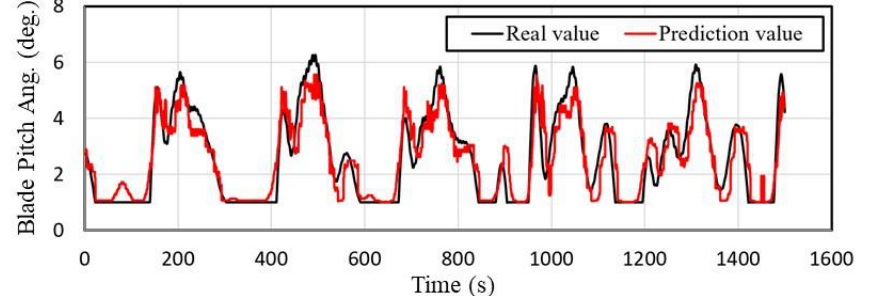
Figure 10. Comparison of actual and predicted values for application of delay compensation. (Ang., angle.).